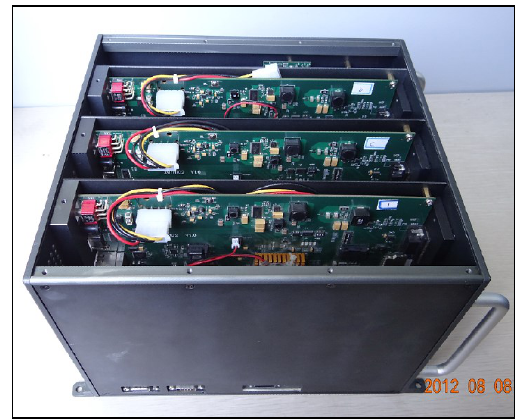
Figure 7. Integration of prototype system